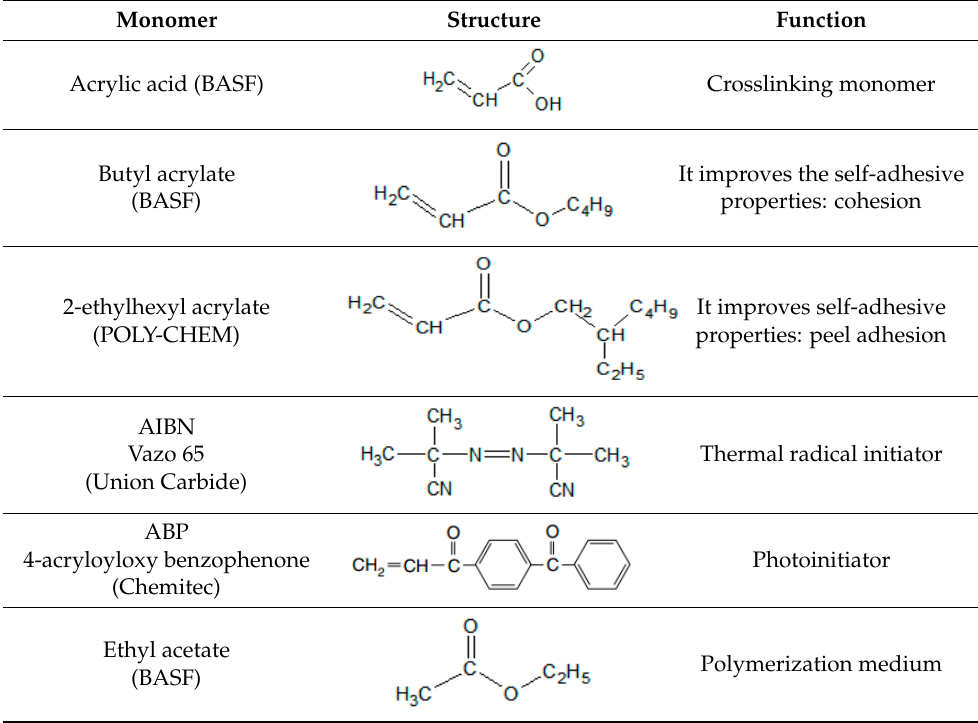
Table 1. Characteristics of monomers and other reagents used for syntheses.